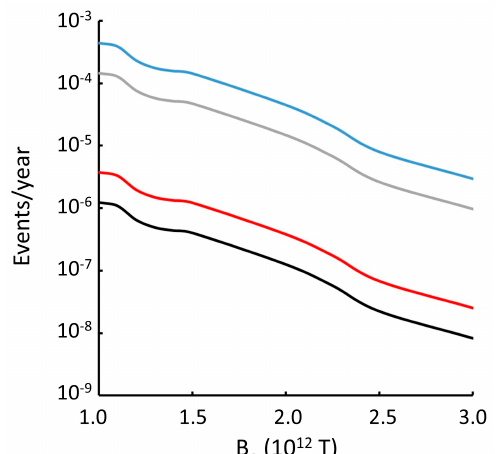
Figure 2. Estimated number of events per year somewhere on Earth as a function of B o for MQNs with 10 5 kg ≤ m ≤ 10 10 kg. The four solid-line curves correspond to event rates based on interstellar dark-matter density [3,42] of ~7 × 10 − 22 kg/m 3 : MQNs transiting through water and emerging with any velocity v exit (blue); MQNs transiting through water and emerging with velocity 10 m/s ≤ v exit ≤ 100 m/s (gray); MQNs transiting through granite and emerging with any velocity v exit (red); MQNs transiting through granite and emerging with velocity 10 m/s ≤ v exit ≤ 100 m/s (black).